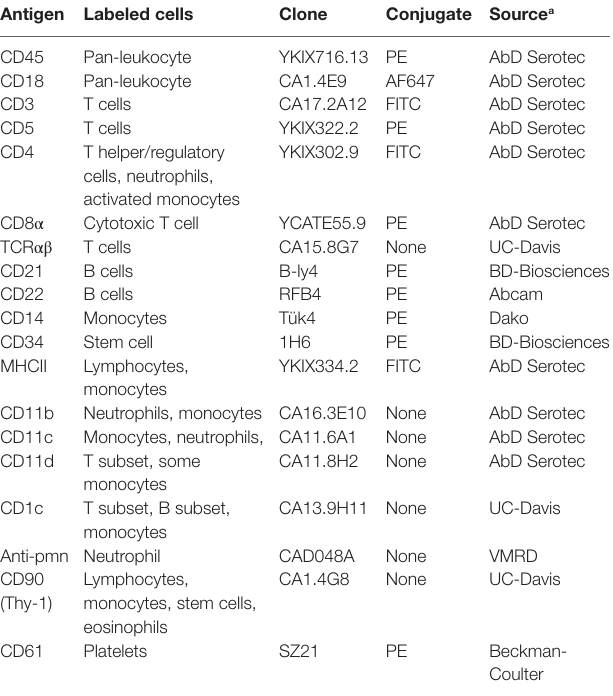
TaBle 3 | antibodies used in flow cytometry at cornell University to label antigens on tumor cells in liquid samples (blood or bone marrow, body cavity fluid, or tissue aspirates) from dogs with acute myeloid leukemia.